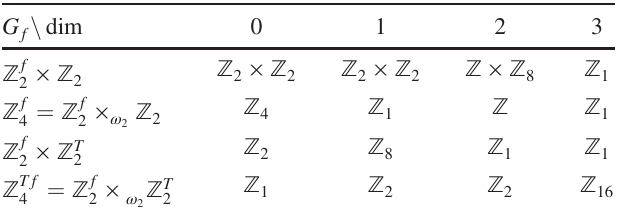
TABLE VII. Classification of fermionic invertible phases with ≅ Z G 2 and different choices of s 1 and b compared to Table VI (with fermionic invertible topological orders included) are emphasized by